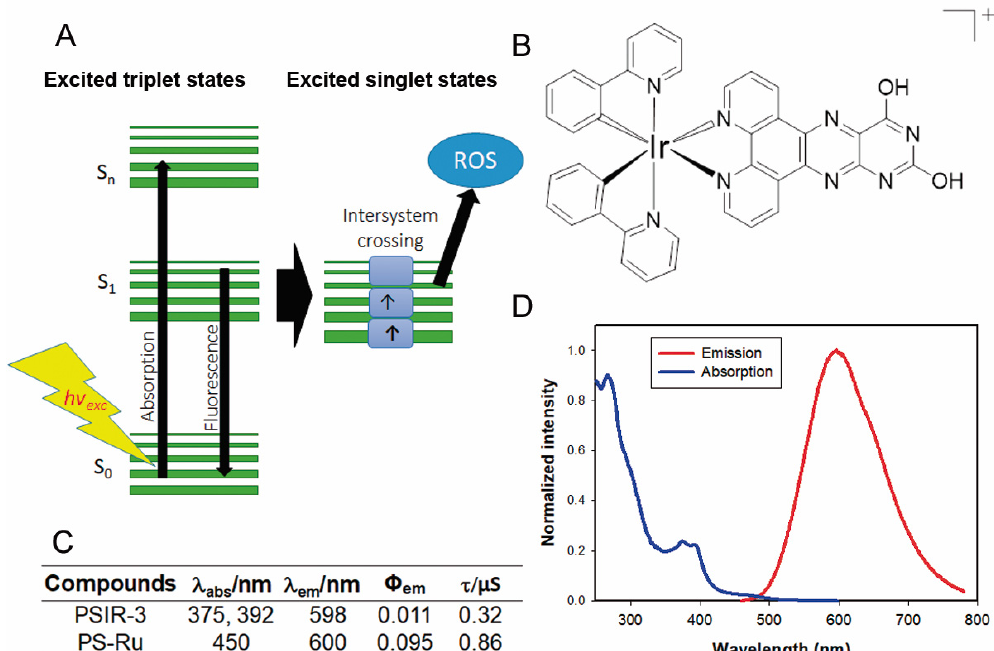
Figure 4. The photophysical properties of the PSIR-3 photosensitizer. ( A ) schematic representation of the absorption– emission process of photosensitizer molecules. Light excites external electrons to accede from a basal state S 0 to a higher energetic state S 1 –S n . Suppose the electrons return to its ground state; the energy is then released as fluorescence. However, when the excited electron enters an intersystem crossing process, the released energy excites molecular oxygen and converts it to reactive oxygen species (ROS). ( B ) chemical structure of the Ir(III) compound (PSIR-3, [Ir(ppy) 2 (ppdh)]PF 6 ). ( C ) Summary of the photophysical properties of the PSIR-3 and PS-Ru compounds, where λ abs = wavelength of absorbance, λ em = wavelength of emission, Φ em = emission quantum yield, and τ = time in the excited state . Data for PS-Ru were obtained from the literature. Adapted from [42], Elsevier, 2010; Adapted from [53], American Chemical Society, 1983. ( D ) The absorption and the emission spectra of the PSIR-3 in acetonitrile (ACN).